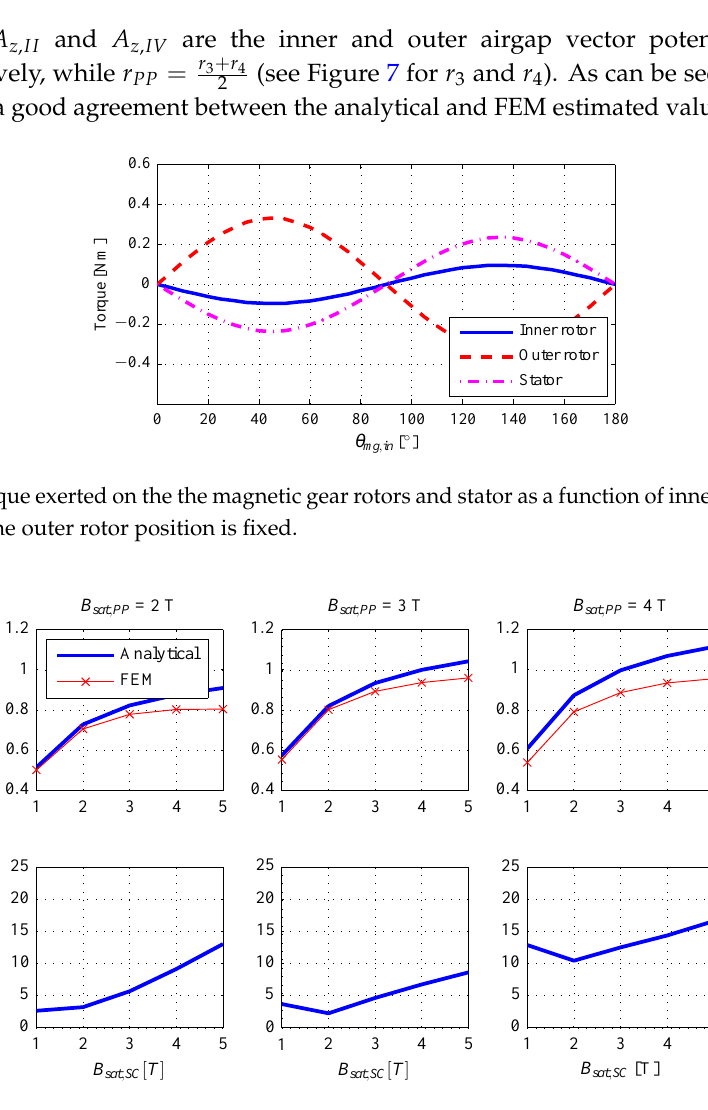
Figure 15. Optimized magnetic gear outer rotor peak torque ˆ T mg , out and its estimation error, as functions of magnetic flux density saturation constraints in the pole-pieces and stator core, B sat , PP and B sat , SC , respectively.